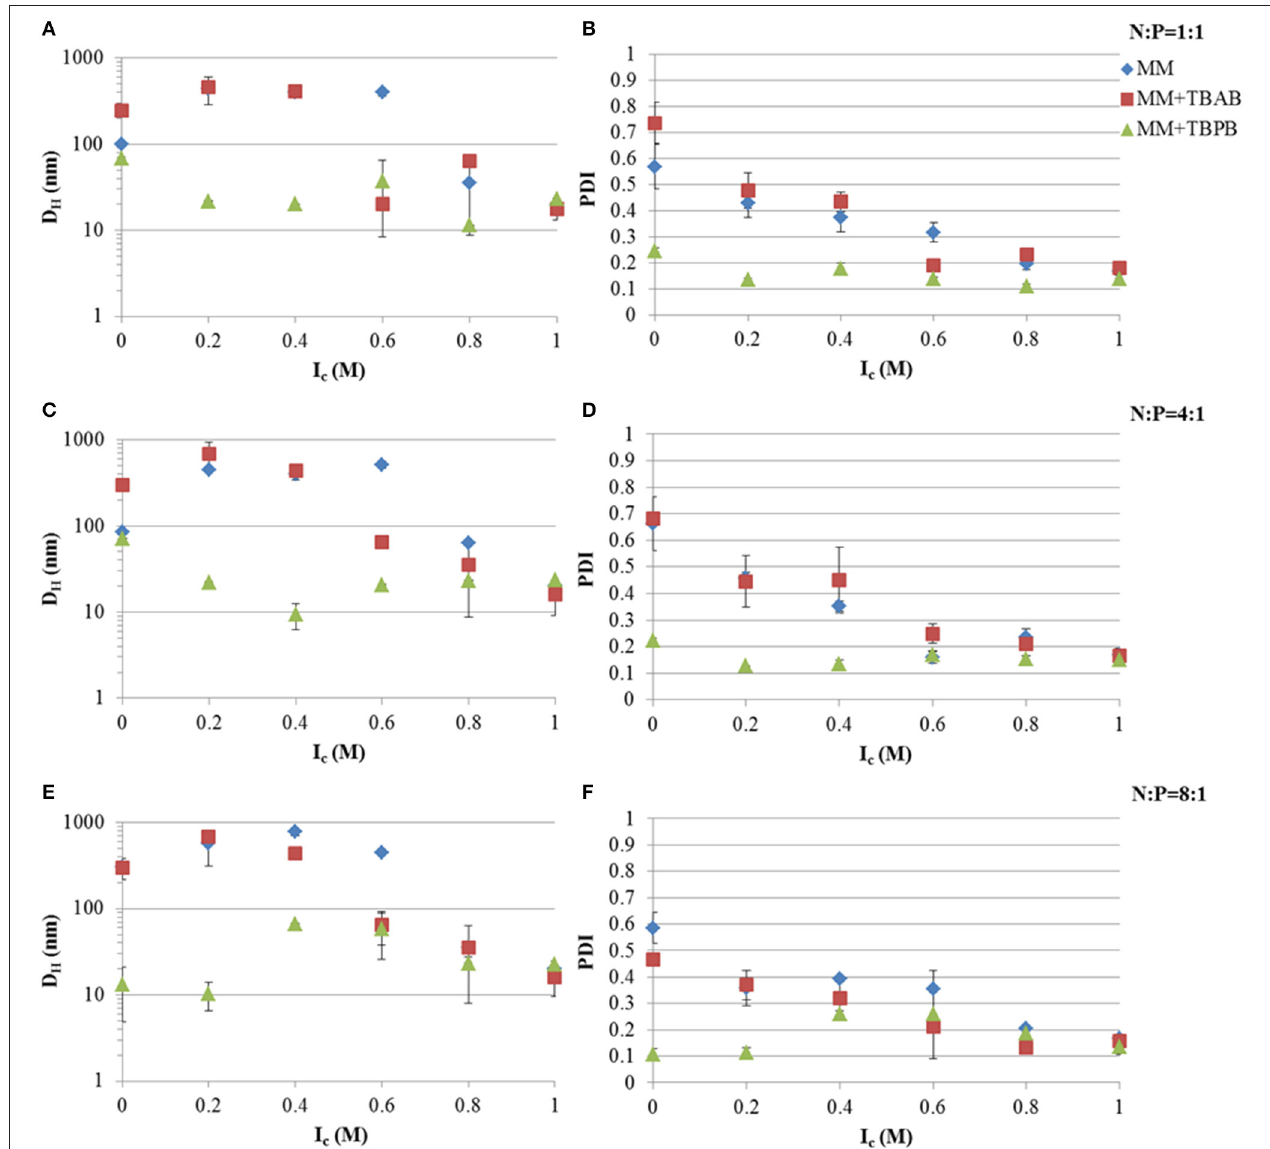
FIGURE 1 | Hydrodynamic diameters (D H ) and PDI at different Tat 2 :dsRNA positive to negative molar charge ratios and ionic strength using CaCl 2 . Charge ratios used were 1:1 (A,B) , 4:1 (C,D) , and 8:1 (E,F) . Data plotted are means ± s.d. ( n = 3) using the CONTIN